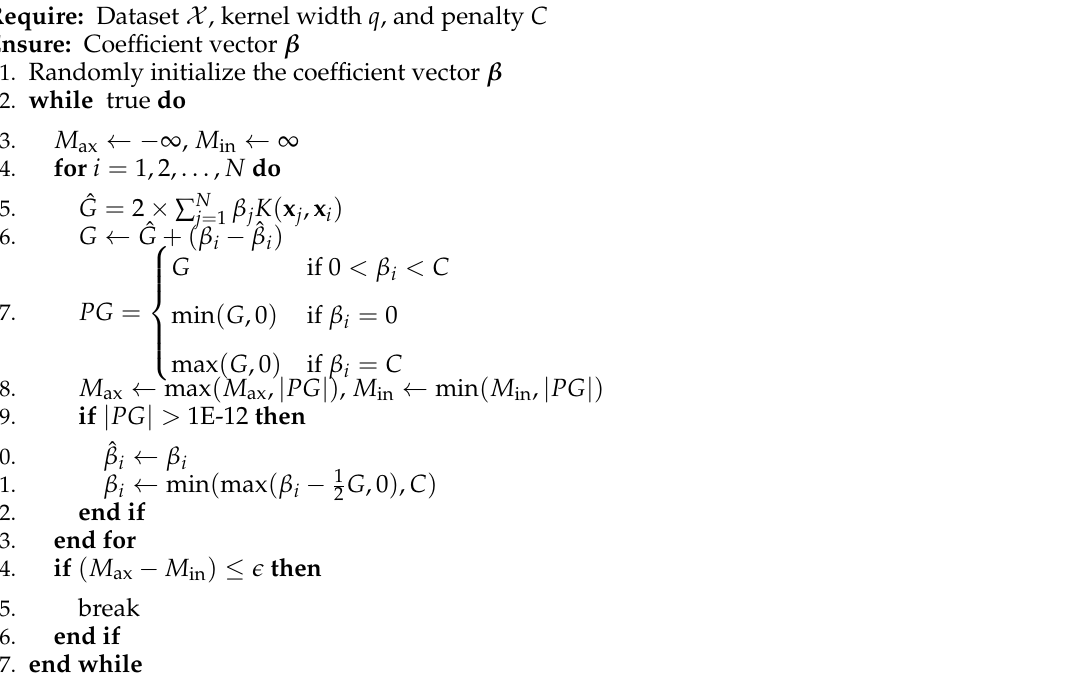
Algorithm 1 DCD solver for SVC’s dual problem in Equation